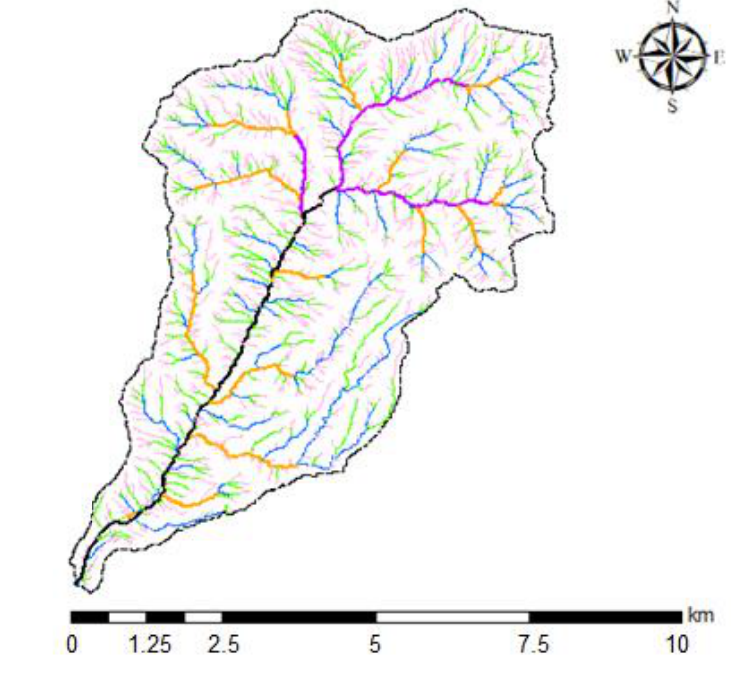
Figure 6. Strahler classification (Source: Authors by ESRI ArcGIS, 2020). Table 2. Precipitation parameters.